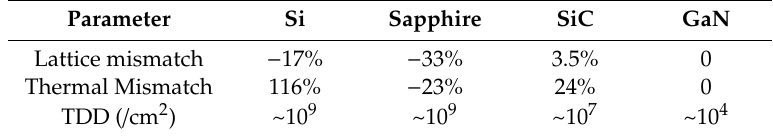
Table 2. Lowest reported threading dislocation density (TDD) in GaN drift layers on di ff erent substrates. Parameter Si Sapphire SiC GaN Lattice